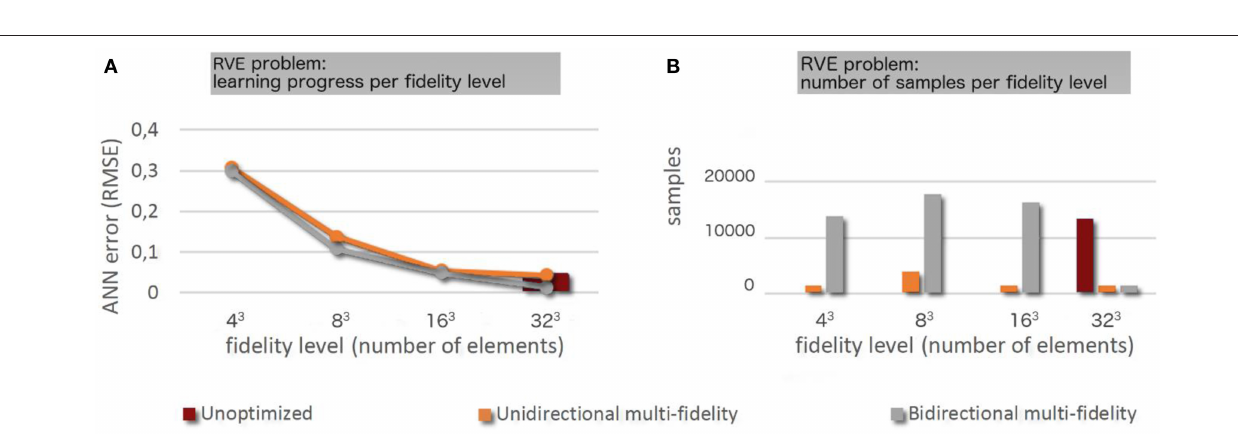
FIGURE 9 | (A) Learning progress across the different fidelity levels for the different training strategies. (B) Number of samples used per fidelity level for the different training